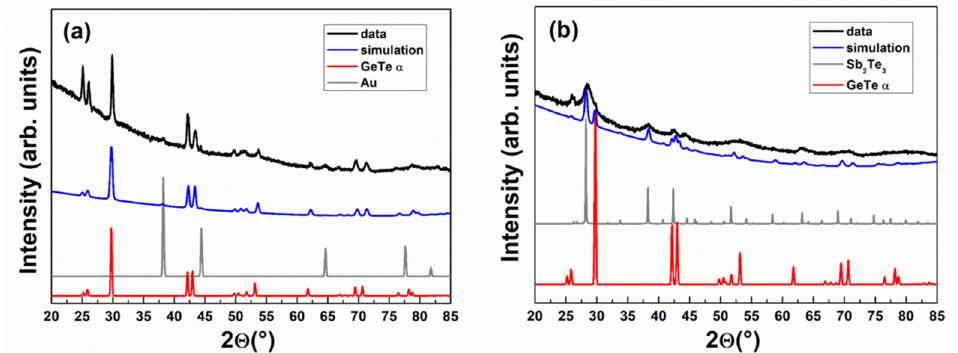
Figure 2. XRD patterns and corresponding simulations on ( a ) GeTe core and ( b ) GeTe/Sb 2 Te 3 core– shell NWs. The powder patterns of Au [40], GeTe [39], and Sb 2 Te 3 [42] are also added for compari- son.